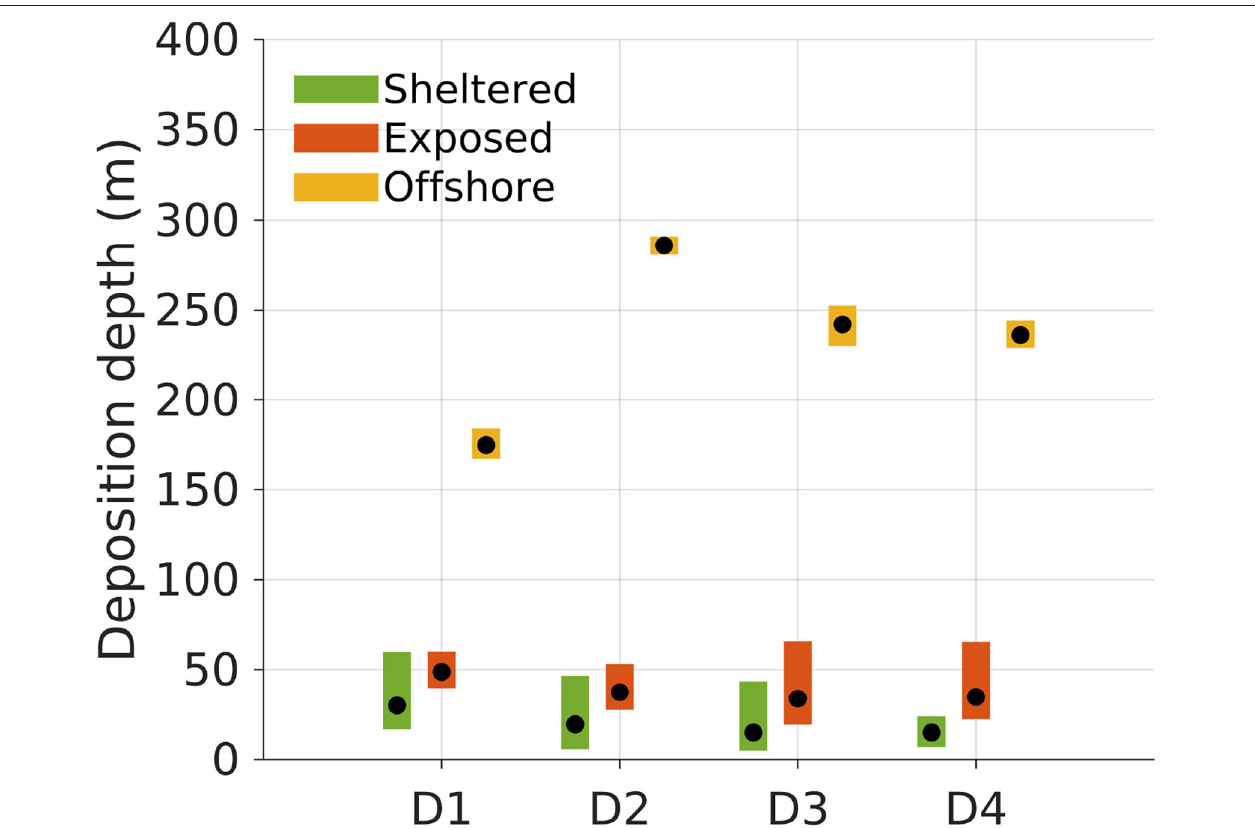
FIGURE 5 | Deposition depths of POM compartments D 1 to D 4 released from the surface at the three locations (sheltered, 18 m depth; exposed, 40 m depth; offshore, 232 m depth; Figure 1 ). The black dots indicate the median deposition depth of the POM for each release site and compartment. The colored bars represent the 95% confidence intervals for the median deposition depths based on the simulation results. The confidence intervals were computed by bootstrapping, extracting 10,000 subsamples from the original deposition field 100,000